Question: What does this figure show? Answer in one sentence.
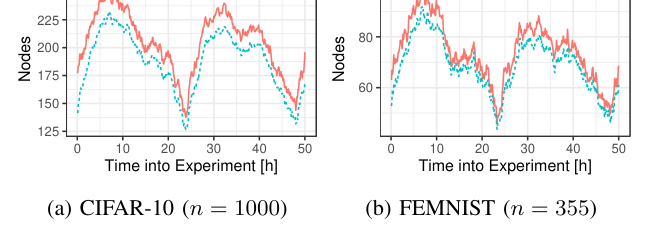
Answer: The number of online nodes, and the average number of online nodes in the views of participating nodes for the CIFAR-10 and FEMNIST datasets.